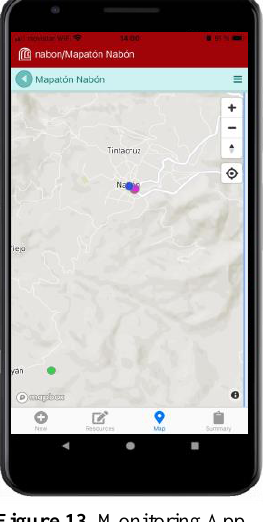
Figure 13 . Monitoring App